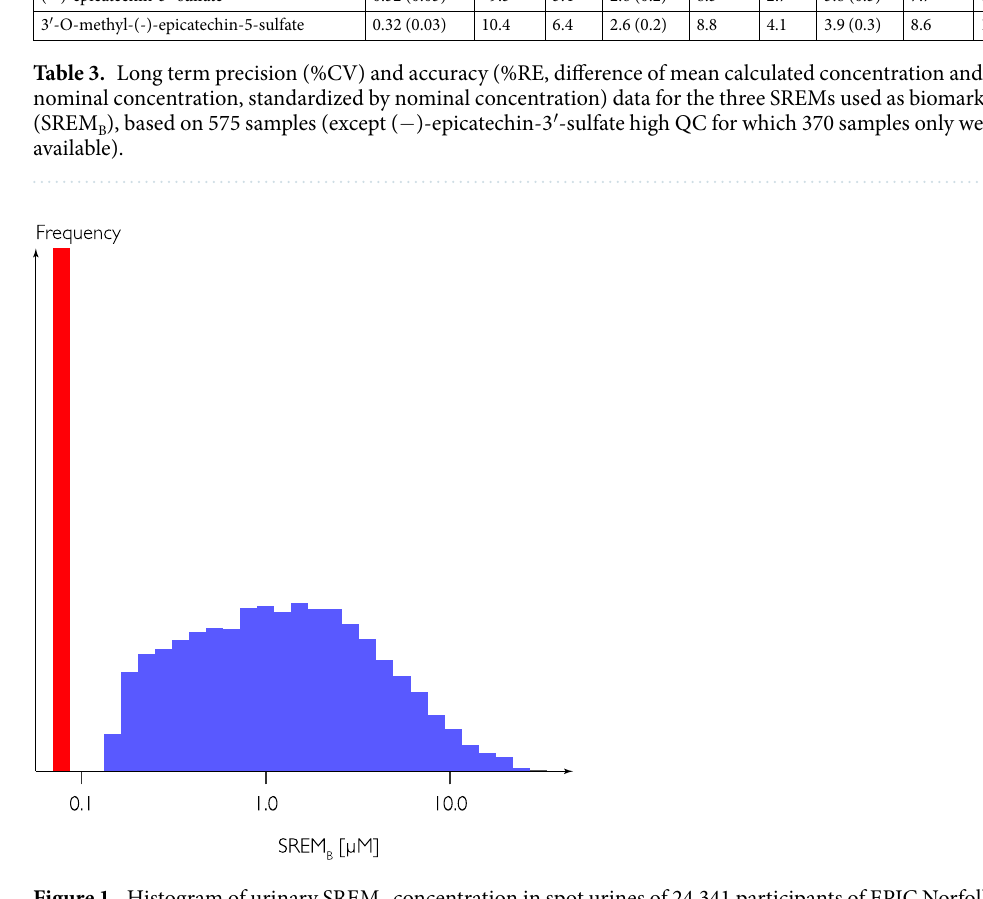
Figure 1. Histogram of urinary SREM B concentration in spot urines of 24,341 participants of EPIC Norfolk. The lower limit of quantification was 0.1 µ